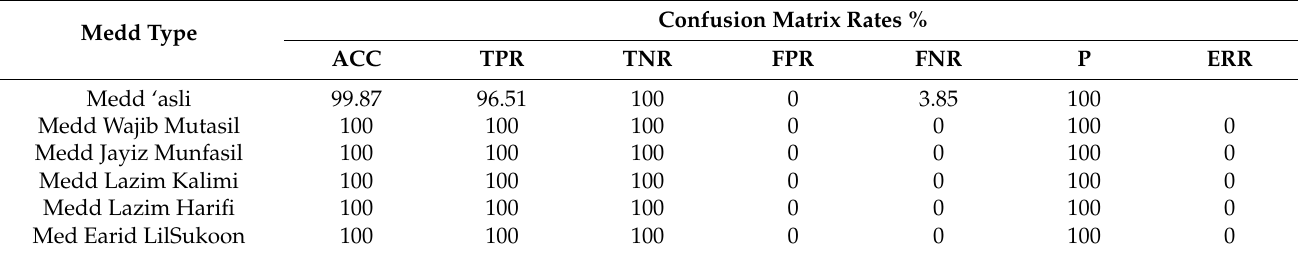
Table 5. Confusion matrix rates for RPDAMC